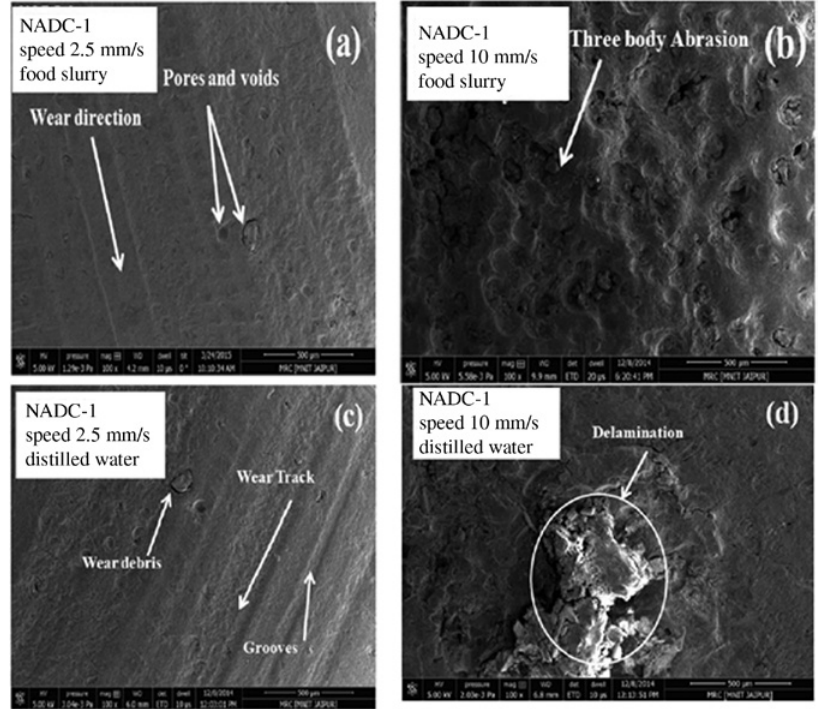
Figure 11: FE-SEM images of worn surfaces of composite filled with 1 wt.% nanoalumina under the normal load of 40 N and temperature of 25 ° C, and the varying chewing speed of (a) 2.5 mm/s, food slurry; (b) 10 mm/s, food slurry; (c) 2.5 mm/s, distilled water; and (d) 10 mm/s, distilled water.